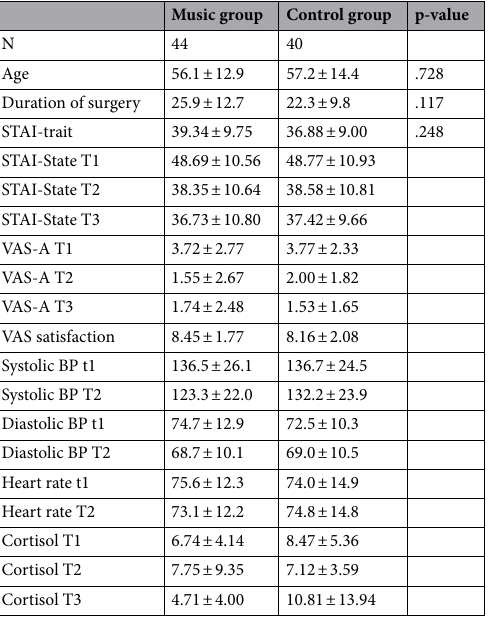
Table 1. Sample characteristics and overview of dependent variables. Displayed are the Mean ± standard deviation. The p-values for the baseline measures are included, highlighting no group differences. T1 in the preparation room ~ 15–30 min prior to surgery, T2 end of the surgery, T3 1 h after the surgery, t1 start of the surgery, STAI state-trait-anxiety inventory, VAS-A visual analogue scale for anxiety, BP blood